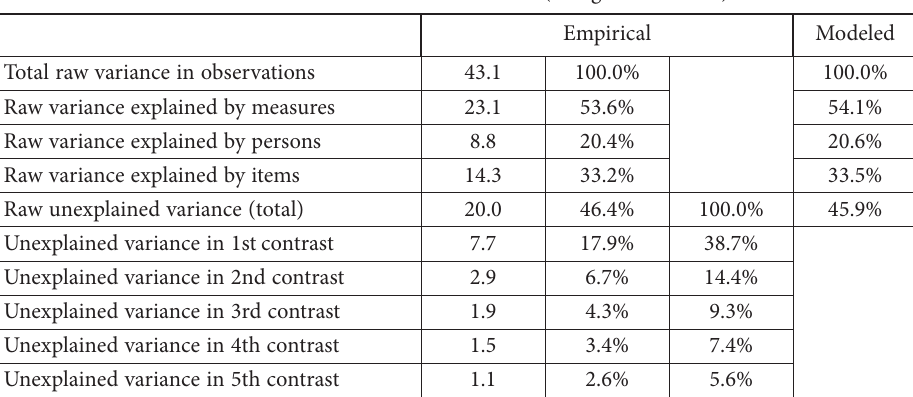
Table 2. Unidimensional analysis (source: created by authors) Table of standardized residual variance (in eigenvalue units) Empirical Modeled Total raw variance in observations 43.1 100.0% 100.0% Raw variance explained by measures 23.1 53.6% 54.1% Raw variance explained by persons 8.8 20.4% 20.6% Raw variance explained by items